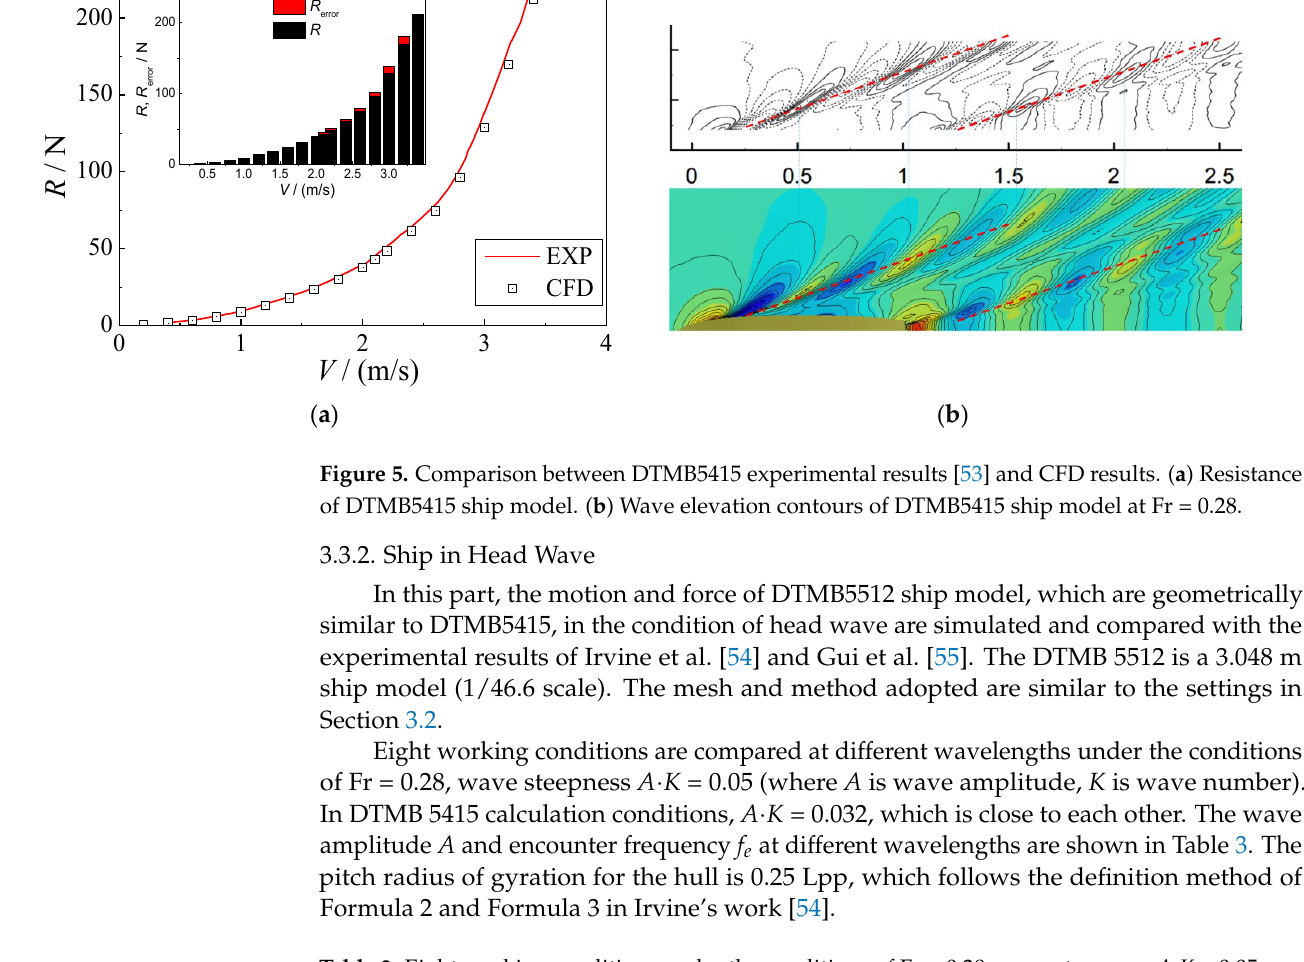
Table 3. Eight working conditions under the conditions of Fr = 0.28, wave steepness A · K =